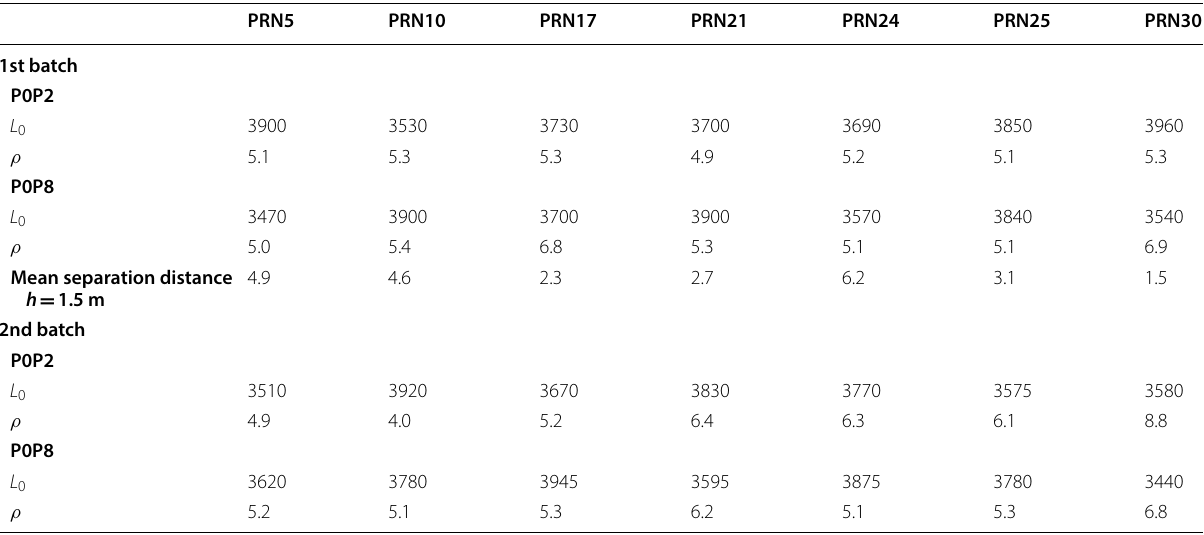
L 0 and ρ are expressed in m. All values given for the outer scale length are approximated to the nearest 5 m. We also give the value of the separation distance at a height of 1.5